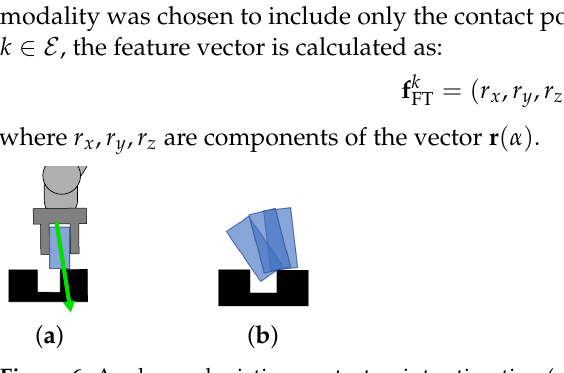
Figure 6. A scheme depicting contact point estimation ( a ) and another example where the grasped part comes into contact with the environment at the same point ( b ). The robot and the gripper are represented by the dark gray shape, whereas the grasped part and the environment are shown in blue and black, respectively. The contact vector estimate is shown with a green